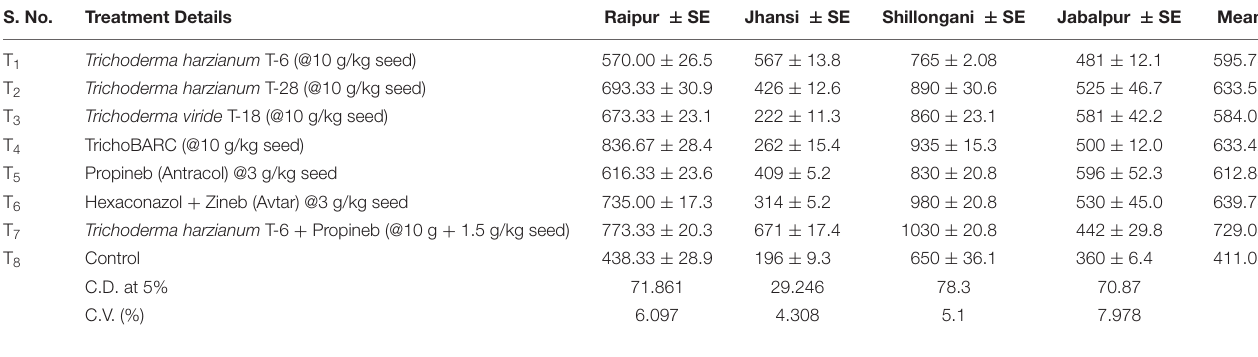
TABLE 3C | Evaluation of new stains of Trichoderma along with fungicides for the management of collar rot of chickpea (2018–2019) – Yield (kg/ha). S.